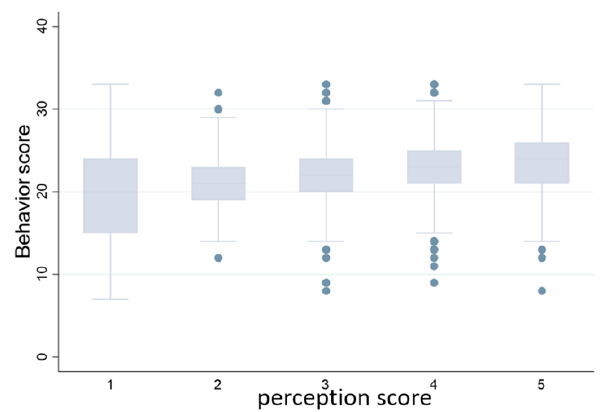
Figure 4. Risk Culture and Pro-environmental Behavior.